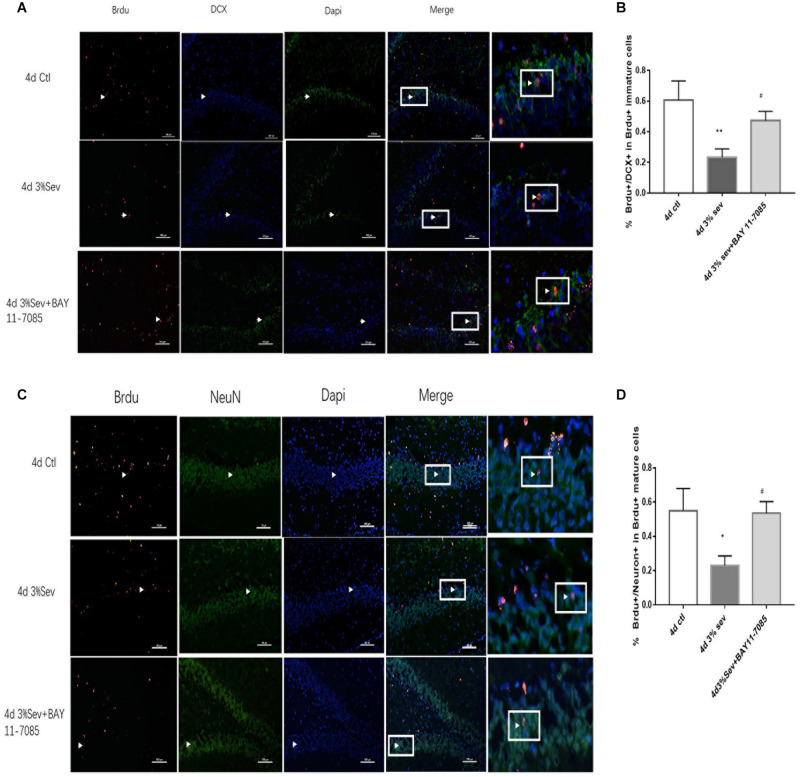
(A) NF-κB inhibitor alleviated sevoflurane-induced decrease of differentiation into DCX in BrdU+ immature cells 4 days after anesthesia. (B) NF-κB inhibitor alleviated sevoflurane-induced decrease of differentiation into NeuN in BrdU+ mature cells 4 days after anesthesia. Scale bar = 100 μm. (C) Quantification (percentage) of BrdU+/DCX+ in BrdU+ immature cells. (D) Quantification (percentage) of BrdU+/NeuN+ in BrdU+ mature cells. n = 3. Values are presented as mean ± SD; *P < 0.05 compared with 4 days control group, **P < 0.01 compared with the 4 days control group, #P < 0.05 compared with 4 days sevoflurane group.